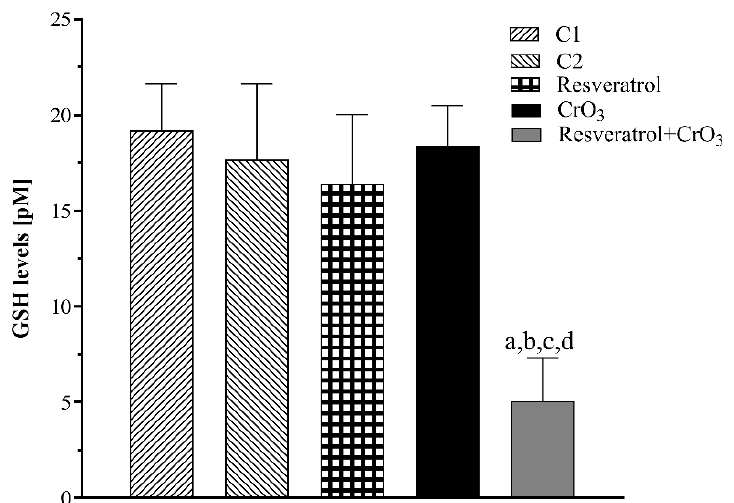
Figure 4. Average glutathione (GSH) levels evaluated in peripheral blood erythrocytes 48 h after treatment with resveratrol and CrO 3 ( n = 5 mice/group). Statistical significance was determined using one-way ANOVA followed by Tukey’s post-hoc test: a p < 0.0001 vs. C1; b p < 0.0001 vs. C2; c p < 0.0001 vs. resveratrol; d p < 0.0001 vs. CrO 3 . C1, Control 1, vehicle only (distilled water); C2, Control 2, vehicle only (ethanol 30%); CrO 3 , chromium trioxide.